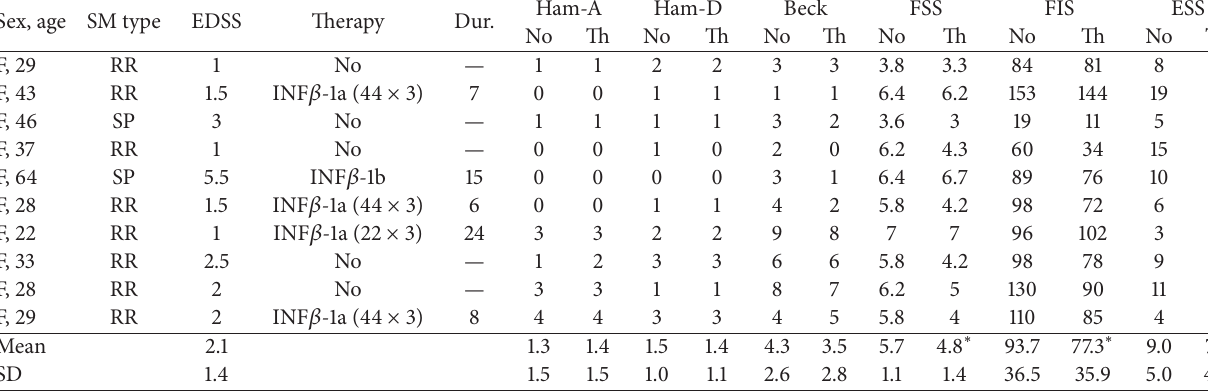
Table 1: Demographics and clinical characteristics of MS patients. RR, relapsing-remitting; SP, secondary progressive; EDSS, Expanded Disability Status State; INF, Interferon; No, patients without Amantadine; Th., patients treated with Amantadine; Ham-A, Hamilton anxiety; Ham-D, Hamilton depression; FSS, Fatigue Severity Scale; FIS, Fatigue Impact Scale; ESS, Epworth Sleepiness